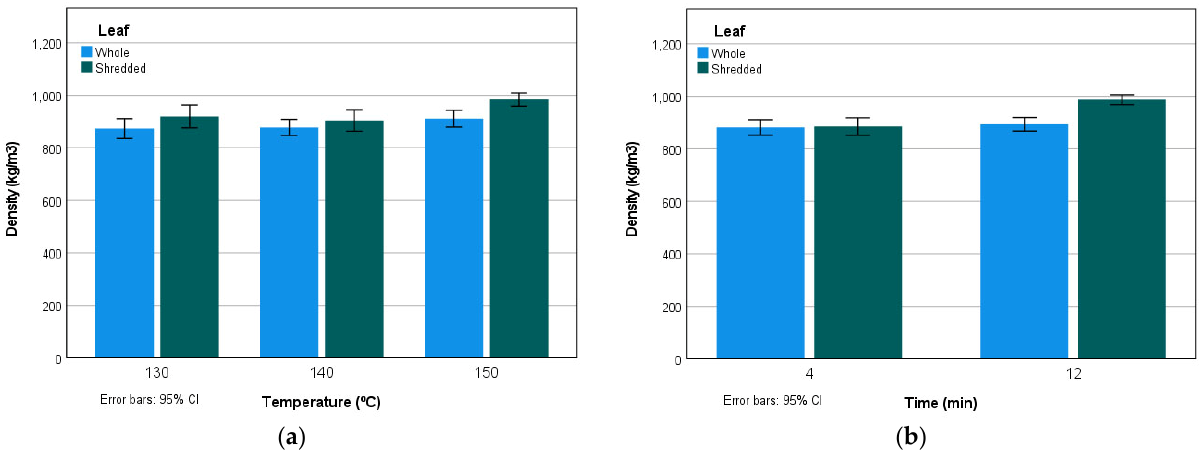
Figure 4. Density according to ( a ) temperature and ( b ) pressing time. CI: confidence interval. Whole-leaf panels produced lower thickness swelling (TS) at 24-h (13.66 to 18.33%) Figure 5. Thickness swelling (TS) after 24 h according to ( a ) temperature and ( b ) pressing time.